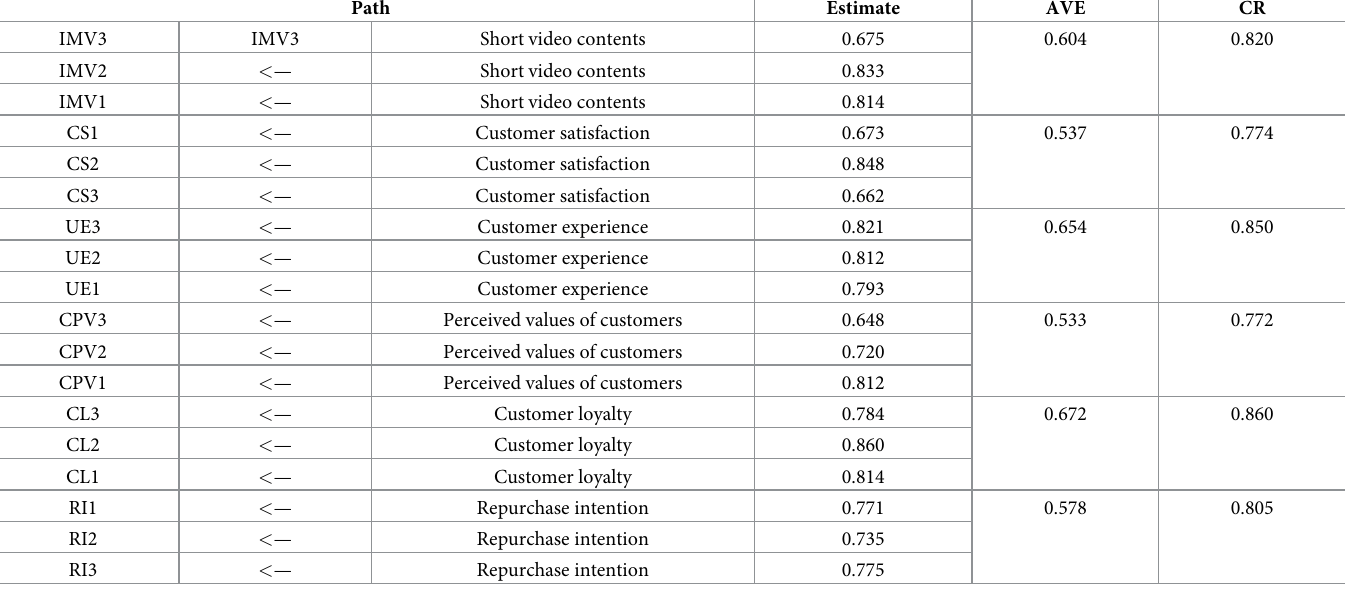
Table 5. Results of convergent factor